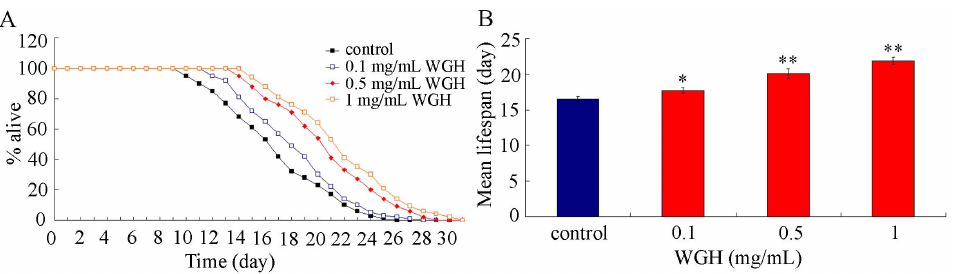
Figure 2. Effects of WGH treatment on lifespan of C.elegan . (A) Lifespan curves of nematodes treated with WGH. (B) Comparison of mean lifespans in nematodes treated with WGH. WGH treatment was performed throughout the lifespan of nematodes from L4-larvae. WGH, wheat gluten hydrolysate. Bars represent means 6 S.E.M. * p , 0.05, ** p , 0.01.